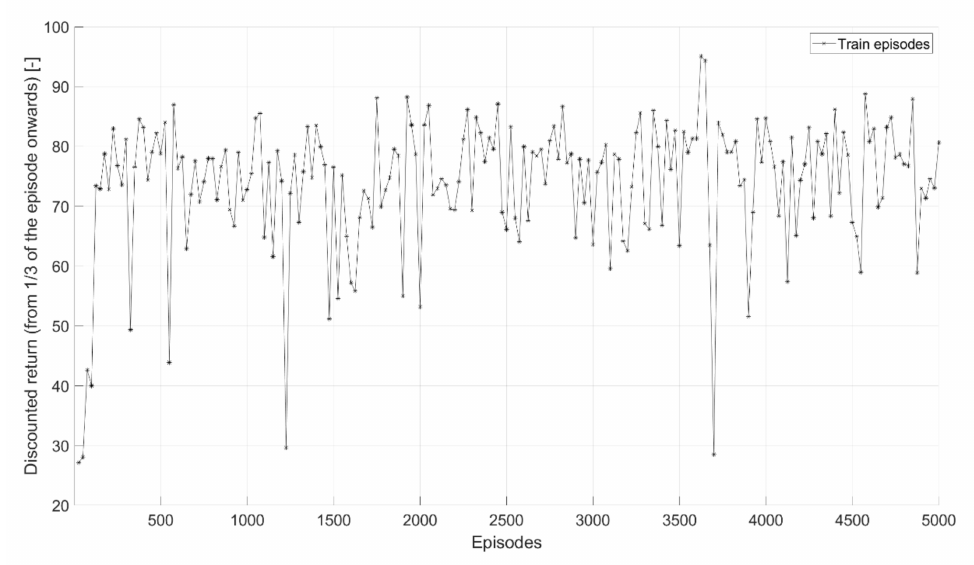
Figure 11. Discounted return of the training episodes calculated at 1/3 of the CLUST1 for γ = 0.9.